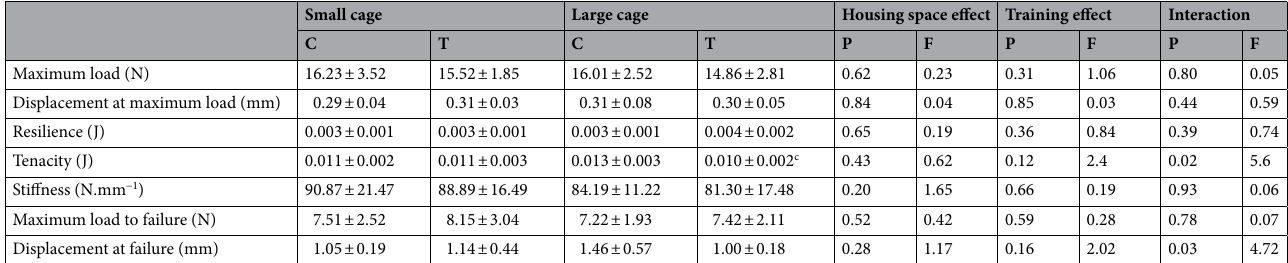
Table 2. Maximum load (force) (N), displacement at maximum load (mm), resilience (J), tenacity (J), stiffness (N.mm −1 ), displacement at failure (mm) and maximum load (force) to failure (N) of mice femur for the control (C) and trained (T) groups kept in small cage (SC) and large cage (LC). Data are in mean ± standard deviation (SD). Statistical analysis: We used two-way ANOVA for identifying the effects of housing space and training, and post-hoc Newman Keuls to trace differences among groups. Statistical difference symbol: c- different from LC-C (P ≤ 0.05).